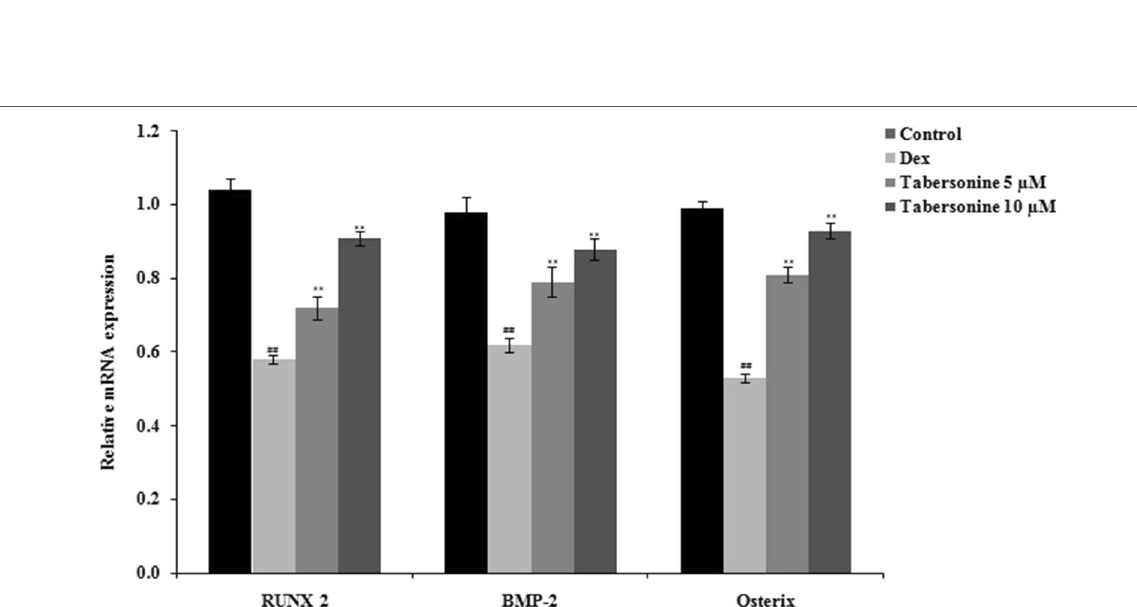
Fig. 6 Effects of tabersonine on the levels of mRNAs encoding RUNX2, BMP-2 and osterix in dexamethasone-treated osteoblasts. Means ( n 10). ## p < 0.01 vs. control, ** p < 0.01 vs. Dex =